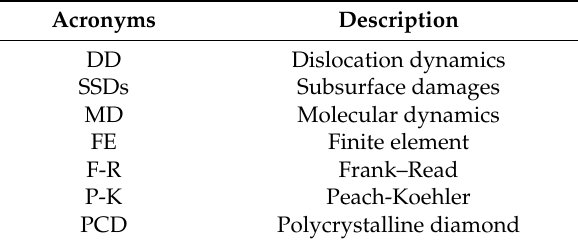
Table 2. Acronyms involved in this